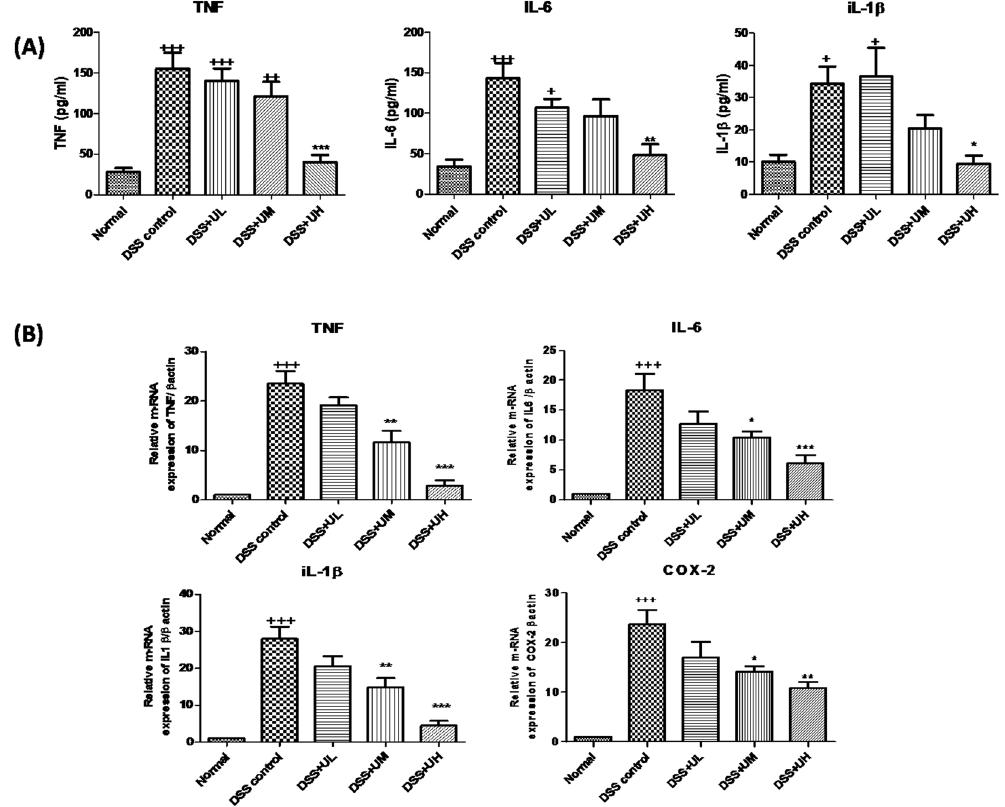
Figure 5. Effect of uridine treatment on the inflammatory biomarkers of DSS induced UC. ( A ) Serum proinflammatory cytokines level TNF, IL-6 and IL-1 β measured by cytometric bead array assay. ( B ) m-RNA expression of pro-inflammatory cytokines and enzyme in colon tissue measured by RT-PCR. All the values were expressed as mean mean ± SEM (n = 5). +++ p < 0.001 vs Normal, * p < 0.05, ** p < 0.01 and *** p < 0.001 vs DSS